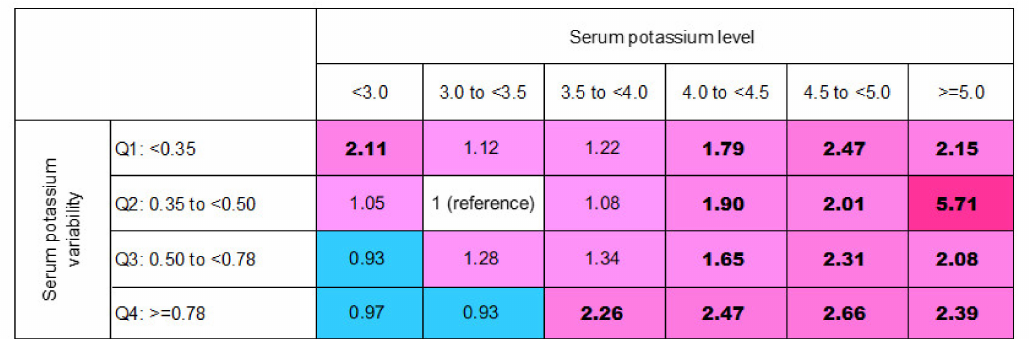
Figure 4. Risk matrices showing the adjusted HRs for in-hospital mortality by using serum potassium level categories and variability in quartiles. The color of the reference cells is white. For HR < 1.0 were represented as blue, while for HR >1.0 was pink. We color the cells from light to dark (away from 1.0). The numbers in bold indicate they are significant ( p < 0.05).